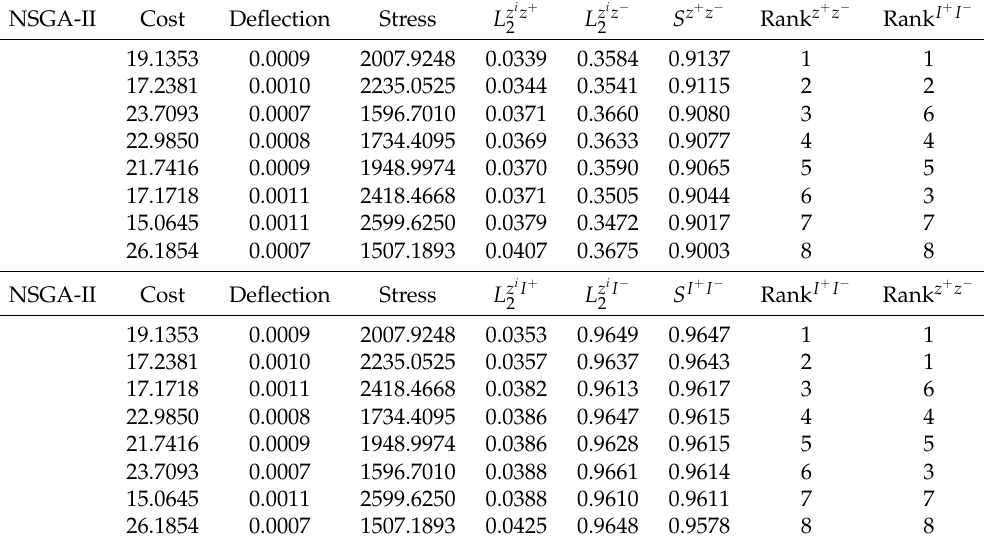
Figure 18. TOPSIS decision with L 1 (top) and L 2 (bottom) metrics and ELECTRE I decision on the approximate POF achieved in a random run for NSGA-II ( N = 50). Table 9. TOPSIS ranking results with L 2 metric for